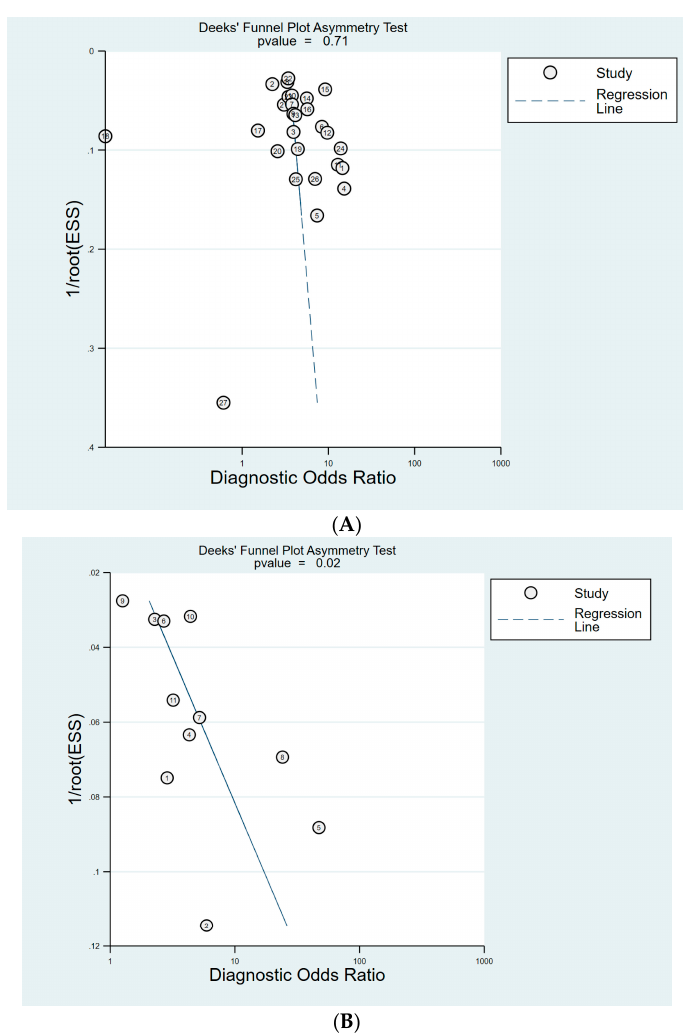
Figure 10. Deek’s funnel plot for the diagnosis of GC. ( A ) cut-o ff value with PG I ≤ 70 ng / mL and PG I / PG II ratio ≤ 3, ( B ) cut-o ff value with PG I / PG II ratio ≤ 3. GC, gastric cancer; PG,